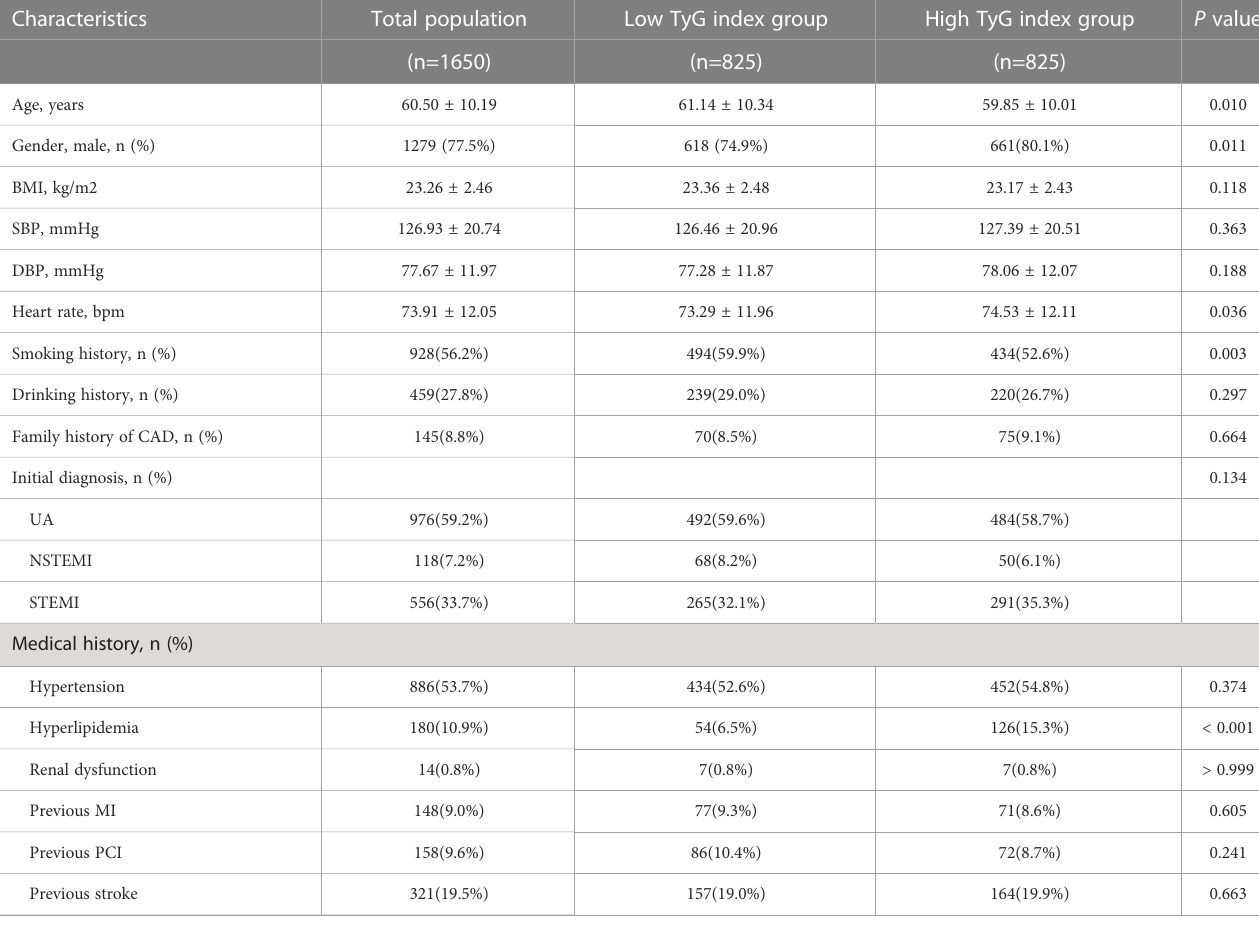
TABLE 1 Baseline clinical characteristics of patients in the low and high TyG index